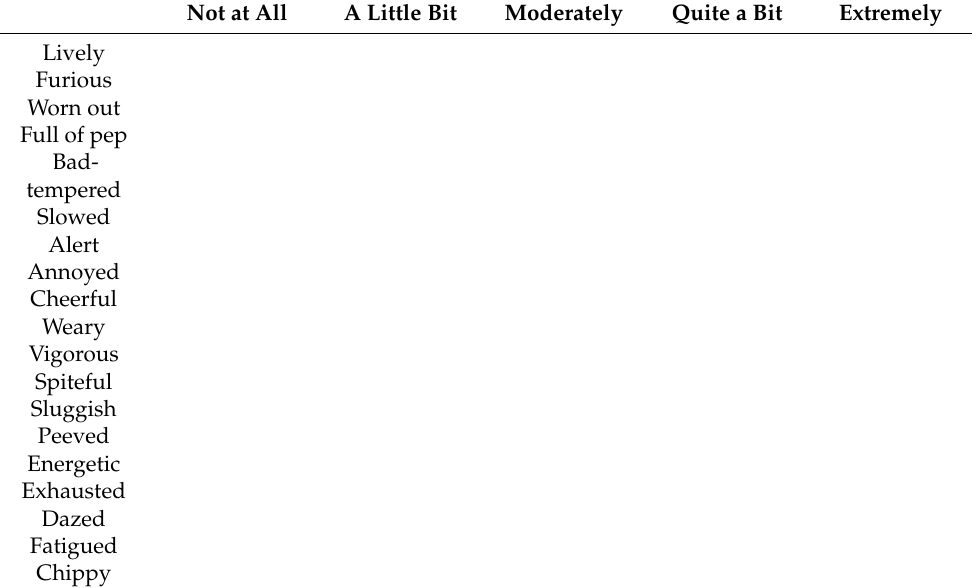
Table A1. Profile of Mood States (POMS) questionnaire; Profile of Mood States (POMS)